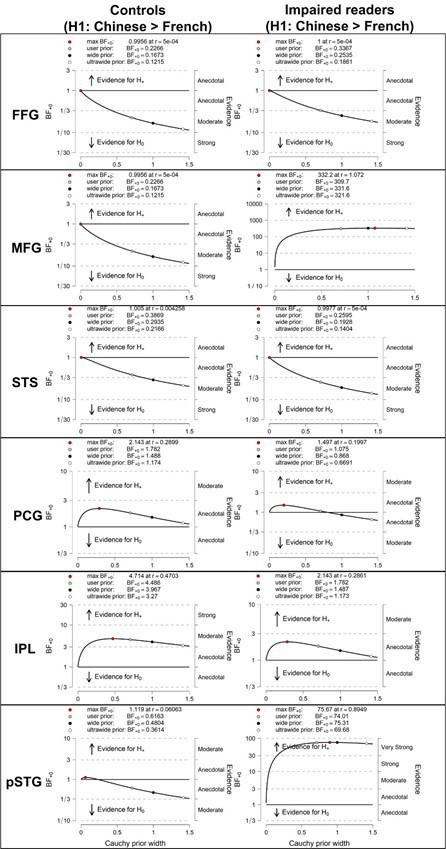
Sensitivity analysis with a variety of priors in the post-hoc pairwise comparisons between Chinese and French children separately in control and impaired-reading children (Left: Controls; Right: impaired-readers).